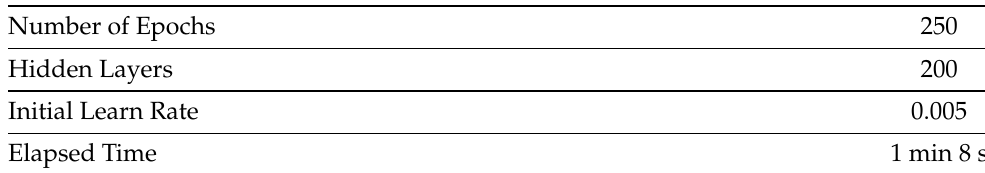
Table 5. Summary of Neural Network architecture in